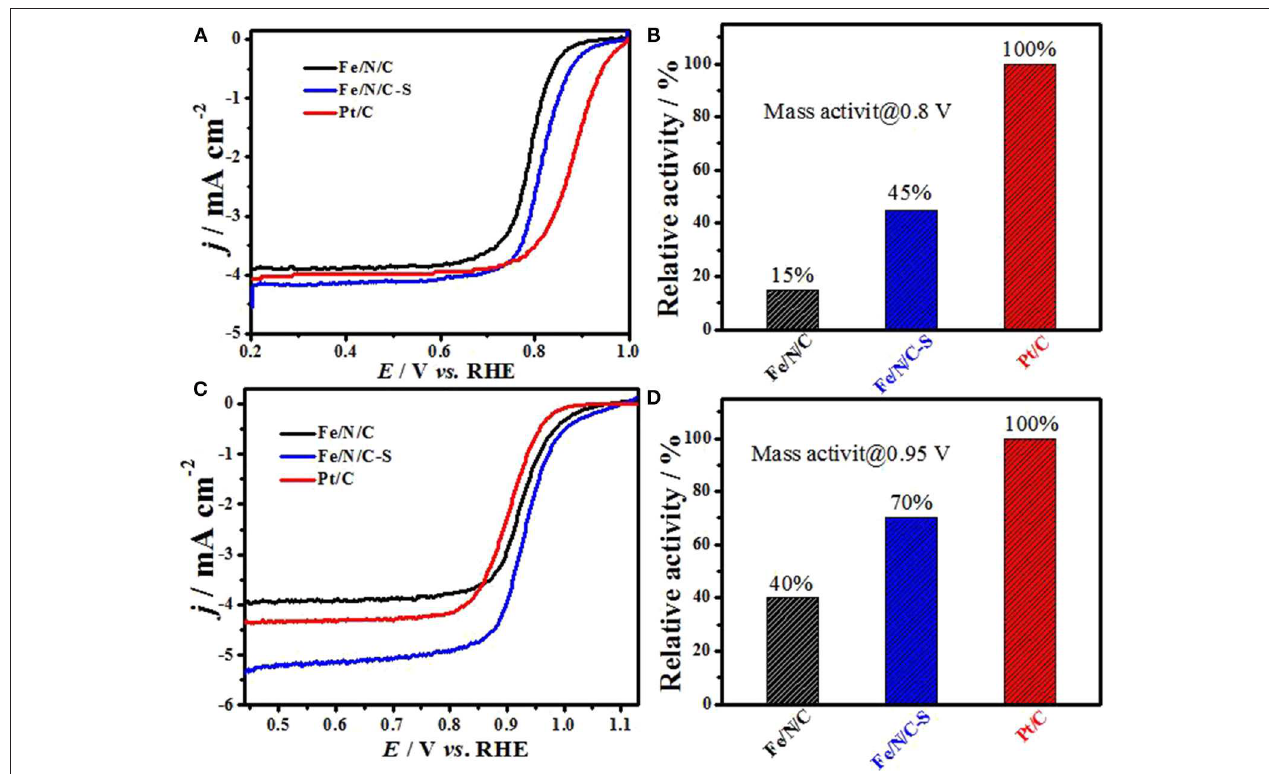
FIGURE 7 | ORR polarization curves of Fe/N/C, Fe/N/C-S and Pt/C catalysts: (A) in 0.1M H 2 SO 4 , (B) comparison of mass activity in alkaline media using Pt/C as reference, (C) polarization curves in 0.1M NaOH, and (D) comparison of mass activity in acidic media using Pt/C as reference.